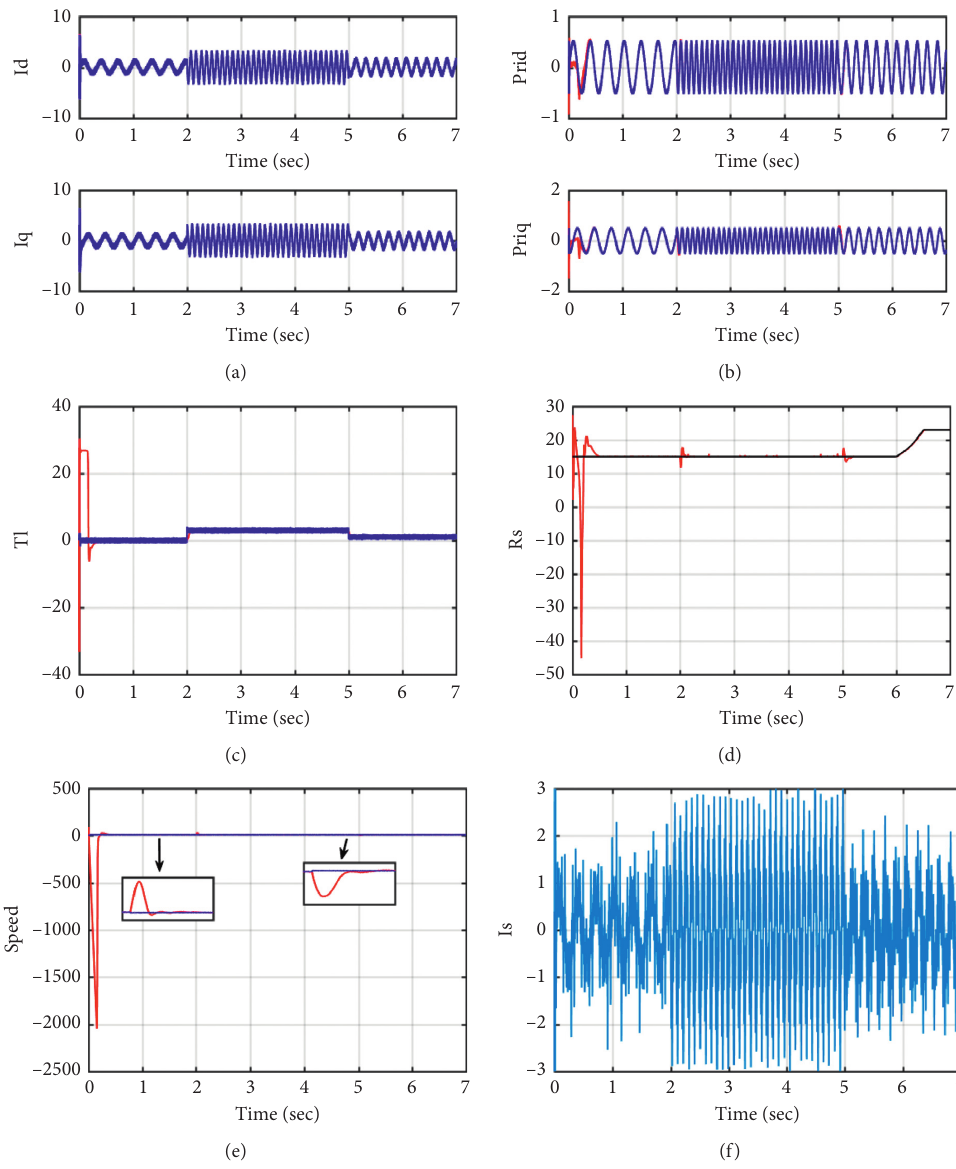
Figure 3: EKF modeling of the six-phase induction motor in low